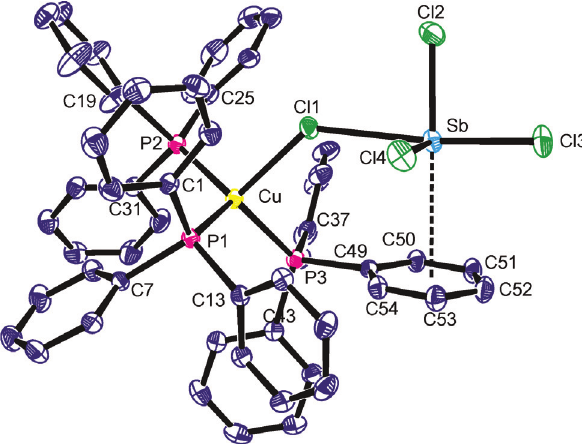
Figure 7 The asymmetric unit of 7 showing the labeling scheme